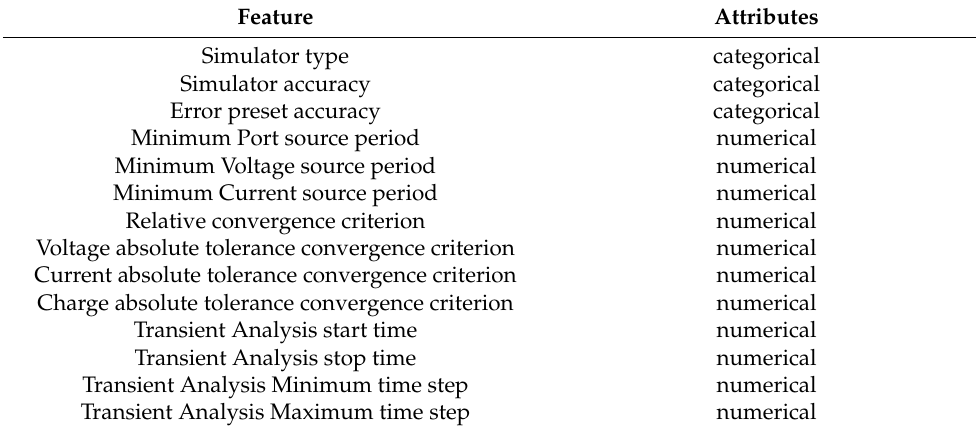
Table 3. Simulation